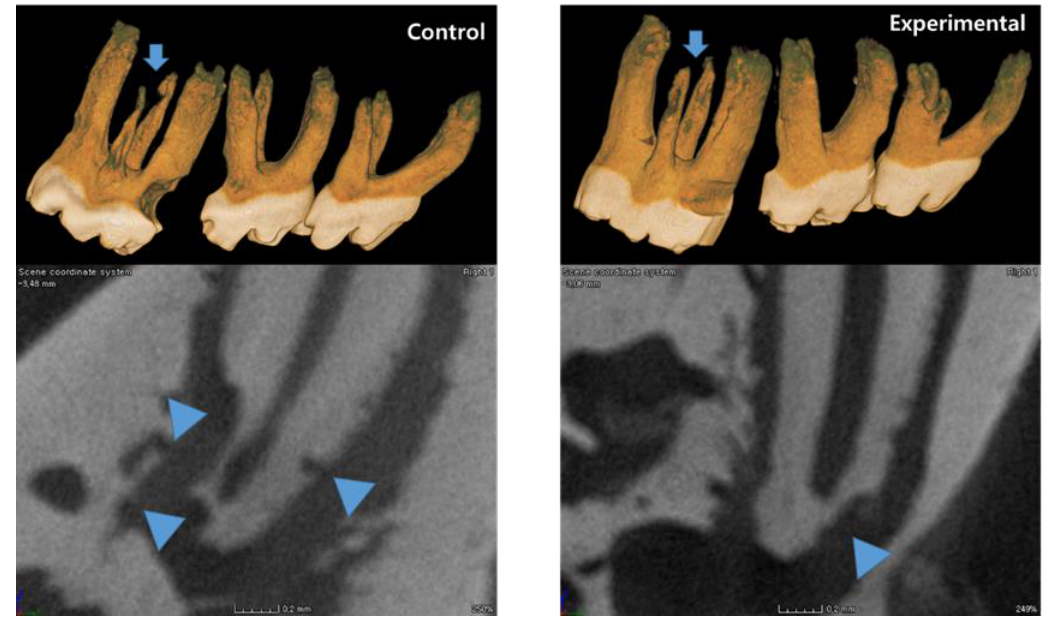
Figure 3. The results of micro-computerized tomography (mCT) analysis. Compared to that in the experimental group, root resorption was more prominent in the control group. Particularly, central roots (arrow) showed extensive resorption in the control group. In a higher-magnification view of the